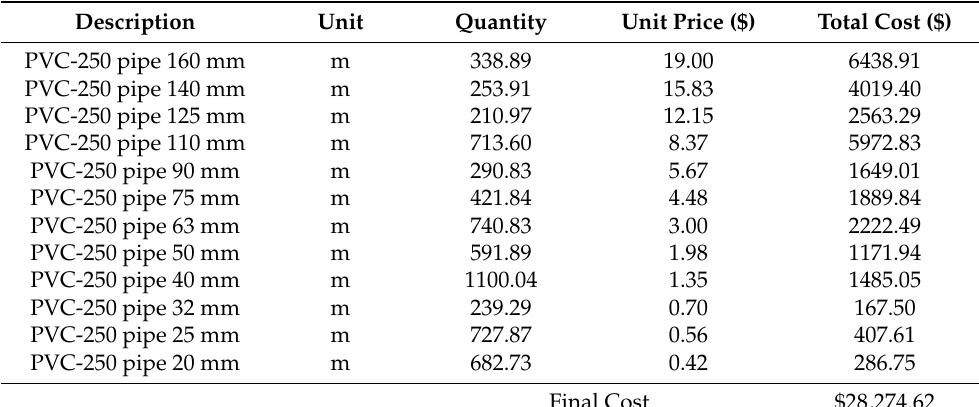
Table 5. Tuncarta network design referential budget with